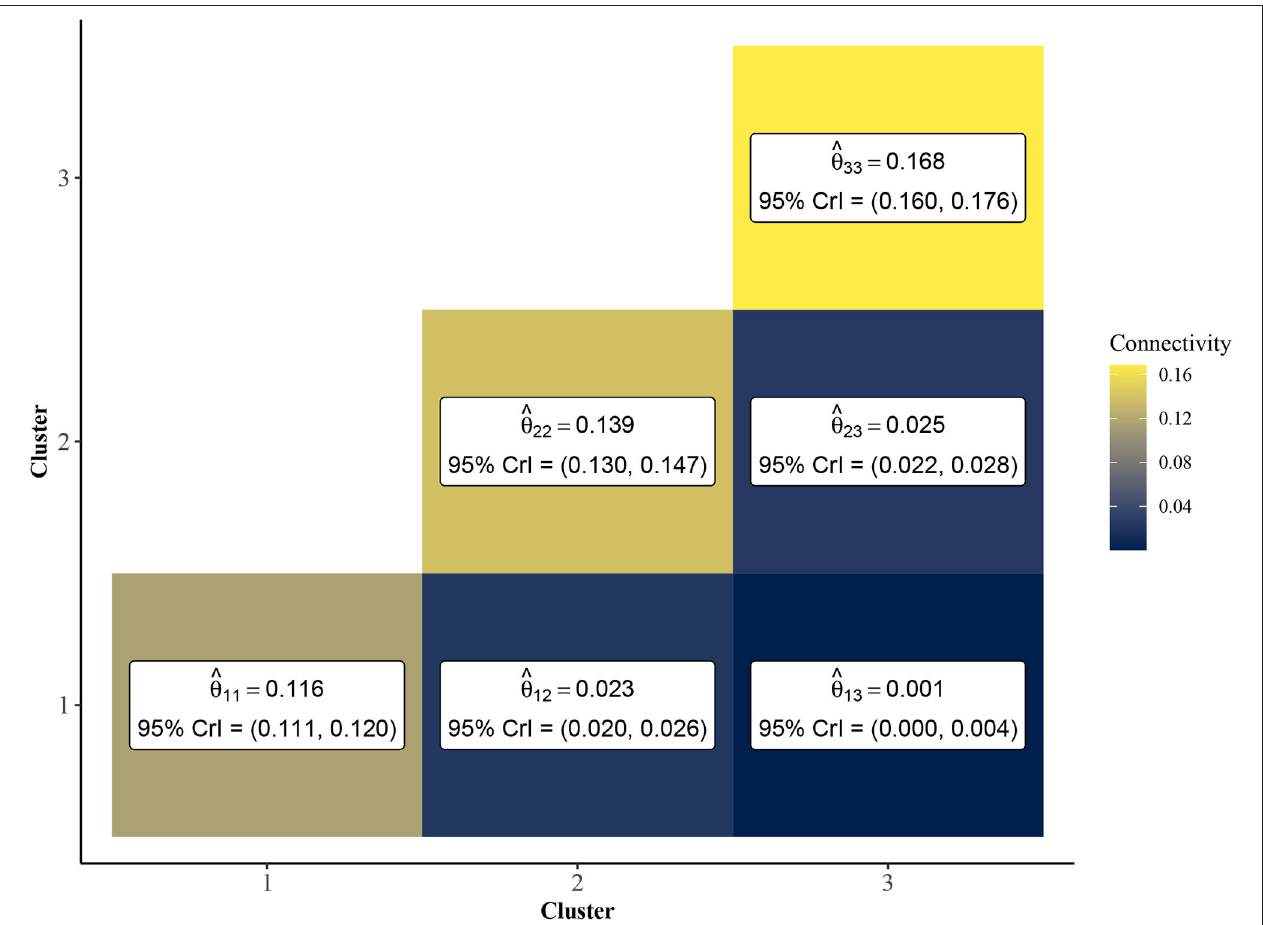
FIGURE 4 | Point estimates and 95% credible intervals of cluster connectivity parameters 2 . The SBM estimates higher values for within-cluster connectivity parameters, θ 11 , θ 22 , and θ 33 , which is indicative of an assortative community structure. Thus, rats within the same community are expected to have significantly higher similarity than rats of different clusters. Clusters 1 and 3 are most dissimilar as evidenced by lower values of ˆ θ 13 relative to ˆ θ 12 and ˆ θ 23